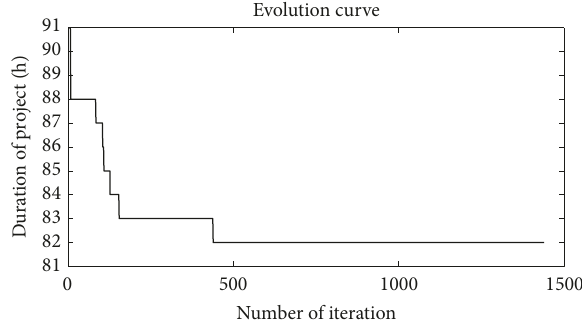
Figure 2: Evolution curve of the instance of J305-2.